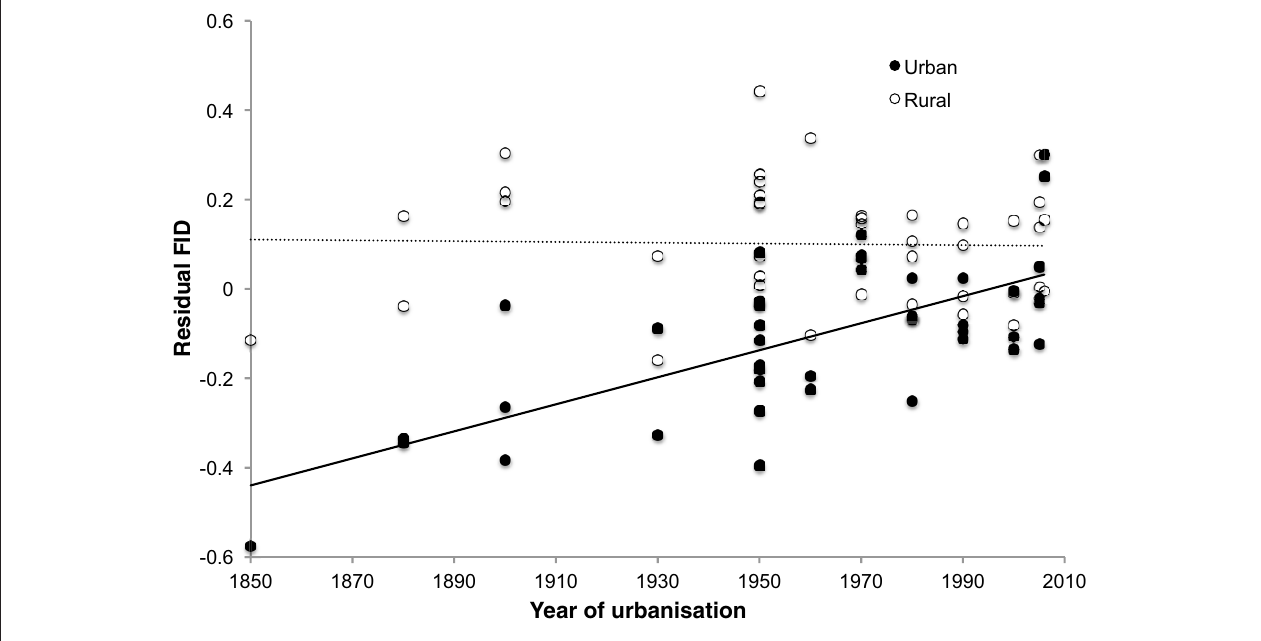
FIGURE 4 | Relationship between FID and year of urbanization in rural and urban populations of 42 bird species. Urban populations of species that have a longer history of urbanization tend to show greater reductions of FID, but there is no such relationship in rural populations of the same species. FID values are the residuals from the regression of absolute log FID against log body mass and log starting